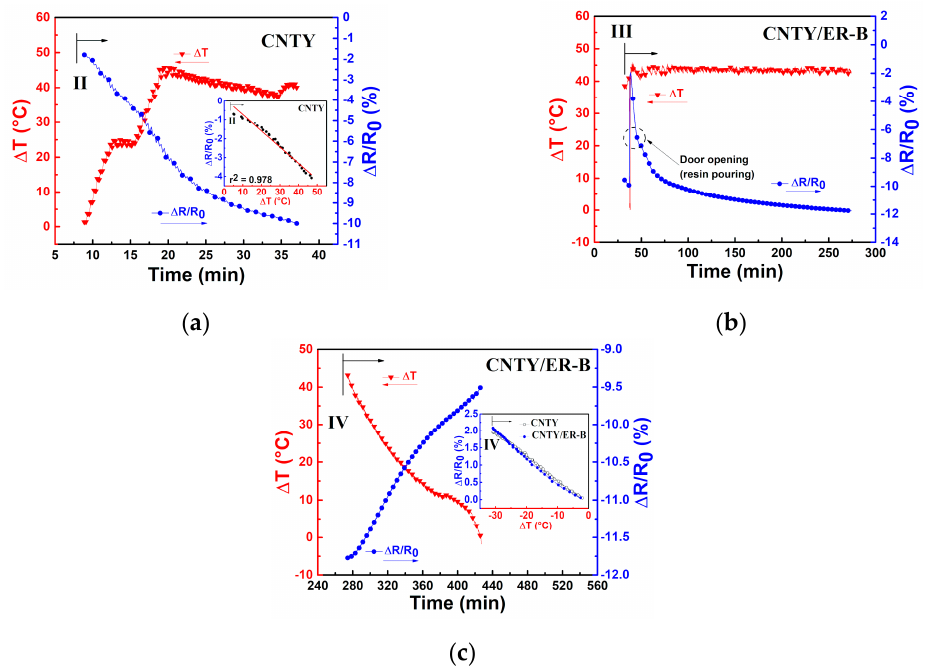
Figure 6. Close-ups of the zones shown in Figure 5 for CNTY/ER-B. ( a ) Heating thermoresistive sensitivity in zone II (freestanding CNTY), ( b ) zone III indicating the moment of resin pouring, ( c ) cooling thermoresistive sensitivity in zone IV (CNTY embedded in resin).